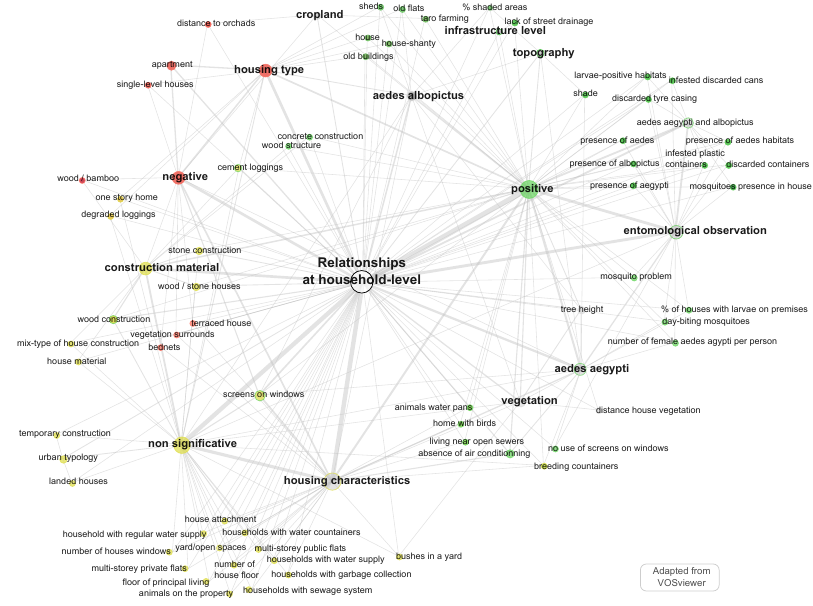
Figure 7. Co-occurrences network mapping of the self-defined keywords related to the landscape factors considered at household-level.